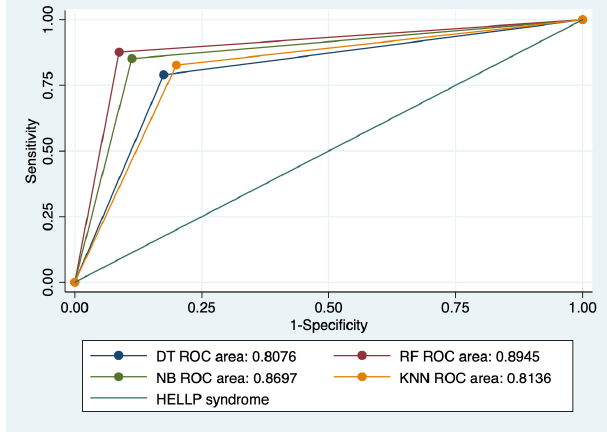
Figure 5. Multiple ROC curves comparison between different machine learning models for all types of HELLP syndrome. Legend: ROC—Receiver operating characteristic; DT—decision trees; NB— naïve Bayes; KNN—k-nearest neighbors; RF—random forest.